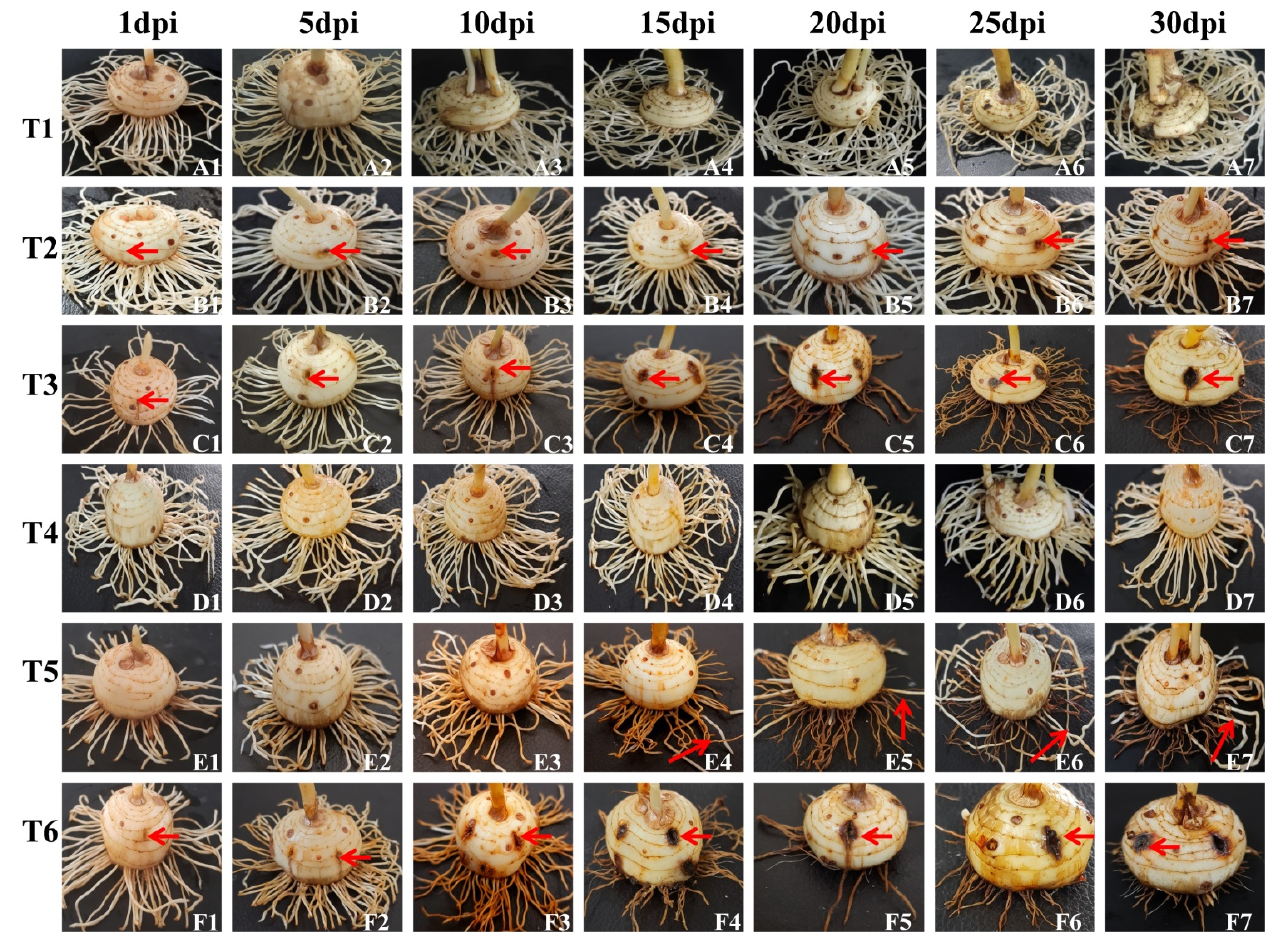
Figure 3. Corm images with different treatments at 1, 5, 10, 15, 20, 25, and 30 dpi (days post inoculation). Six different treatments were given to corms. T1—no injury was given but Fusarium oxysporum R1 (Fox R1) spore suspension was added to soil, T2—only corm injury was given and inoculated with sterile distilled water, T3—corm injury was given and inoculated with Fox R1 spore suspension, T4—only root injury was given and inoculated with sterile water, T5—only root injury was given and inoculated with Fox R1. Arrows in T5 indicate that the uninjured roots were free of infection and were grown normally. T6—the injury was given to both roots and corms and inoculated with Fox R1. In T2, T3 and T6 arrows indicate the injury points on the corm surface. In, T4 (RI only), a slight brown spot at the root tips was observed at 10, 15, 20, 25, and 30 dpi (Figure 3D1–D7. In T5, (RI + Fox R1), browning of root tips started at 1 dpi